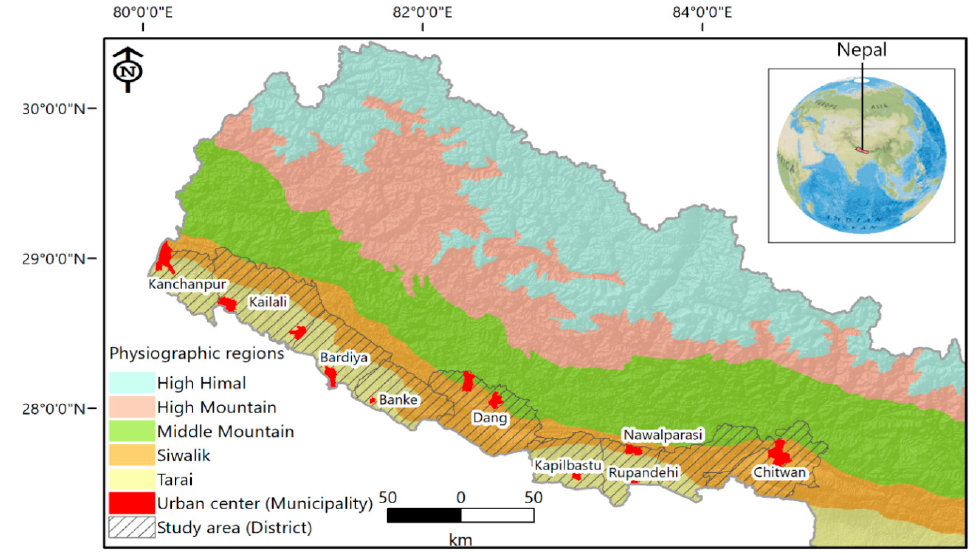
Figure 1. The study area of the western Tarai region, Nepal.